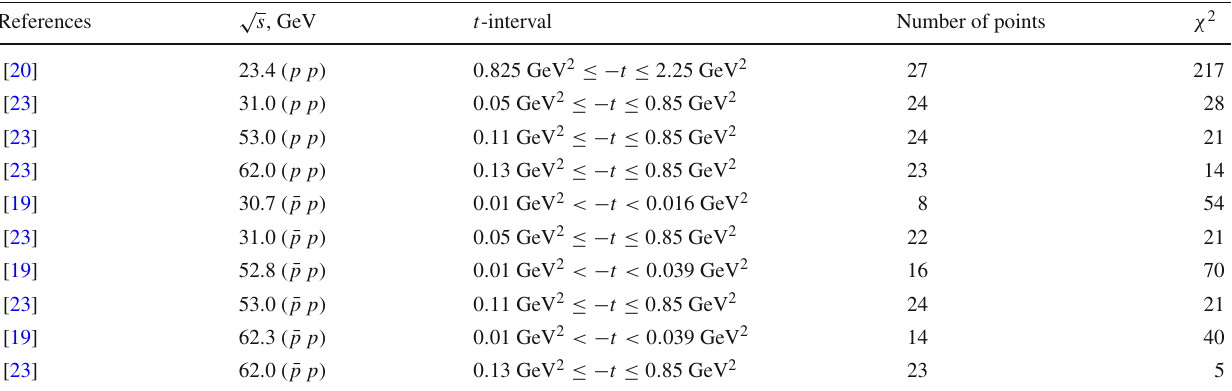
Table 4 The quality of the model description of those ISR data on nucleon–nucleon EDS which were not included into the fitting